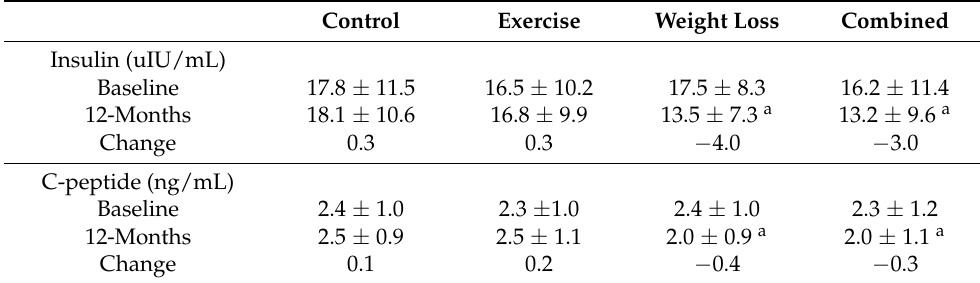
Table 2. Main intervention effects on biomarkers of insulin